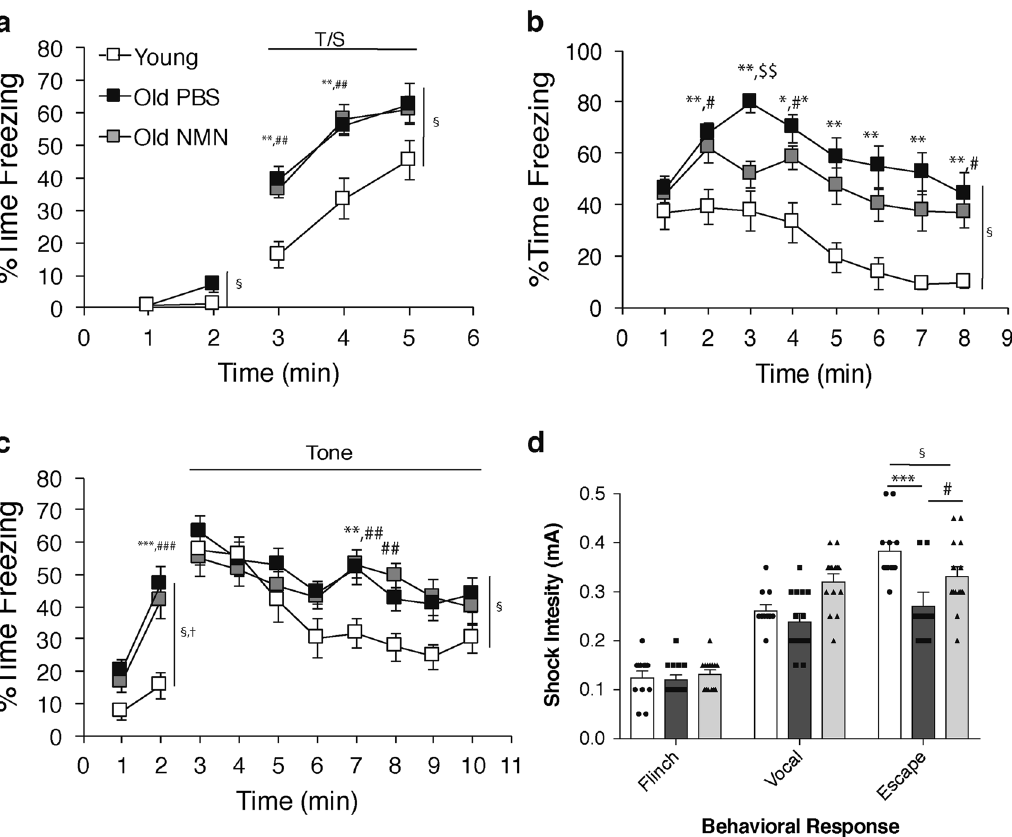
Fig. 2 Old mice exhibit cognitive hypersensitivity, aspects of which are improved by NMN. a – c Contextual fear conditioning tests were conducted on PBS-treated 2-month-old ( n = 12), PBS-treated 20-month-old ( n = 14), and NMN-treated 20-month-old ( n = 14) male mice. Values of percent time freezing are shown for baseline and tone-shock (CS-US) training periods on day 1 ( a ), contextual fear conditioning on day 2 ( b ), and the auditory cue period on day 3 ( c ). Statistical analyses were conducted by two-way repeated measures (rm) ANOVA, and differences at each time point were evaluated by one-way ANOVA. d Shock sensitivities for fl inch response, vocalization, and escape response are shown for the same groups of mice used in ( a – c ). Data are presented as mean ± SE. Signi fi cant group effects and group by time interactions are denoted by symbols at the right sides of the graphs (§ and † , respectively); # p < 0.05, **, ## p < 0.01, *** , ### , $$$ p < 0.001 (**, *** for PBS-treated young vs. PBS-treated old mice; #, ##, ### for PBS-treated young vs. NMN-treated old mice; $$$ for PBS-treated old vs. NMN- treated old